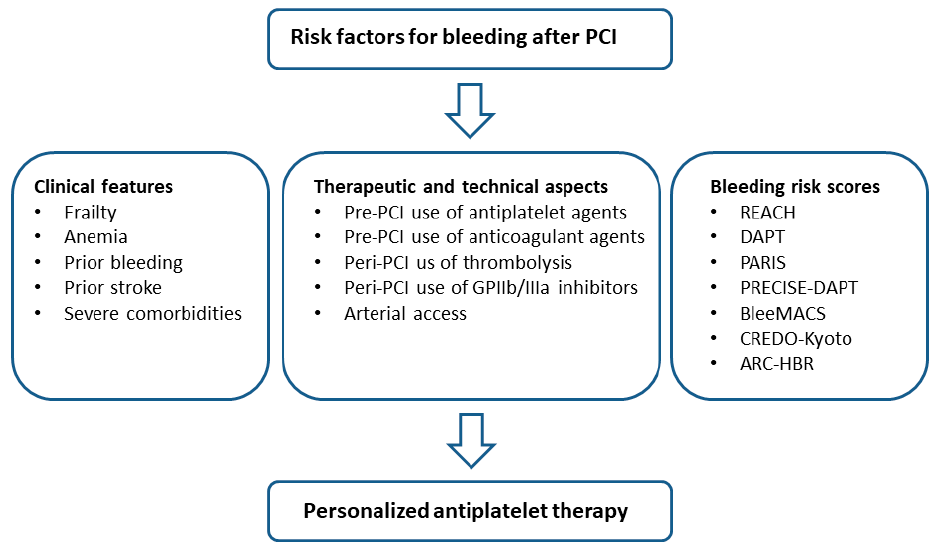
Figure 2. Risk factors to be considered to assess the bleeding risk after percutaneous coronary inter- vention. ARC-HBR: The Academic Research Consortium for High Bleeding Risk; BleeMACS, bleed- ing complications in a multicenter registry of patients discharged with diagnosis of acute coronary syndrome; CREDO-Kyoto: coronary revascularization demonstrating outcome study in Kyoto; DAPT: dual antiplatelet therapy; GUSTO, global utilization of streptokinase and TPA for occluded coronary arteries; PARIS, patterns of non-adherence to anti-platelet regimens in stented patients; PCI: percutaneous coronary intervention; PRECISE-DAPT, predicting bleeding complications in pa- tients undergoing stent implantation and subsequent dual anti-platelet therapy; REACH, reduction in atherothrombosis for continued health